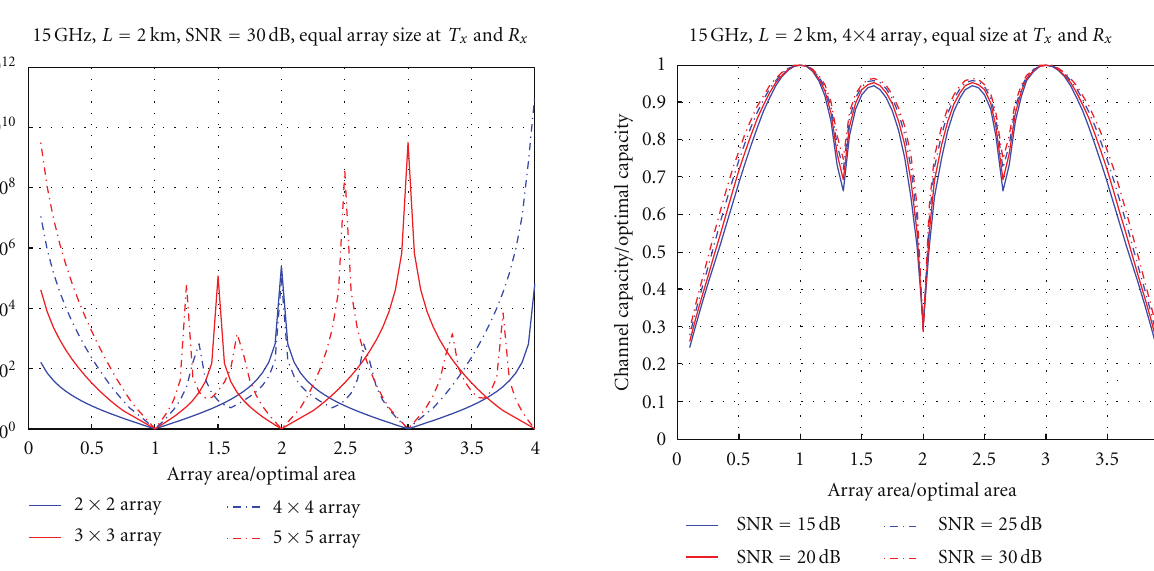
Figure 5: Channel capacity versus antenna array area.